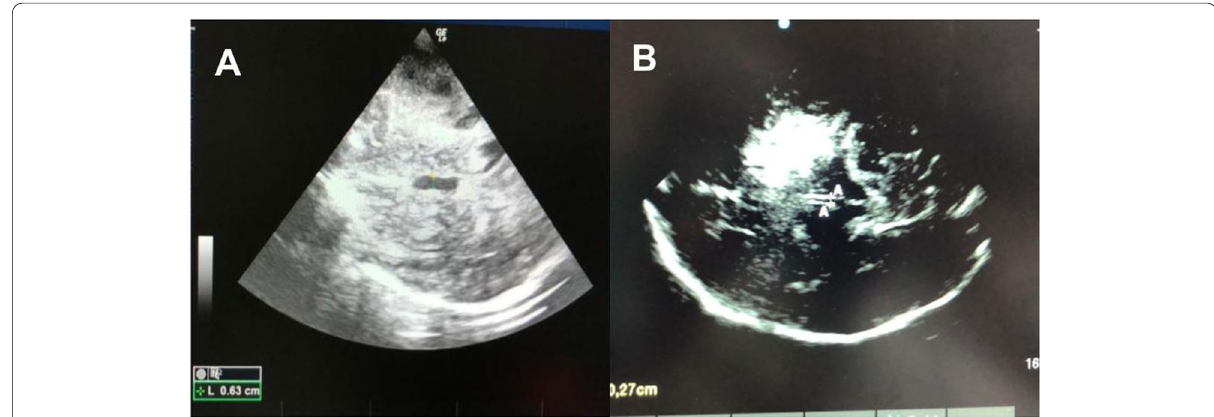
Fig. 6 Diencephalic plane, the third ventricle is obtained (A-A). It should be measured the largest transverse diameter of the third ventricle with its hyperechogenic margins. These figures were performed of two women patients, with same ages, 24h after derivation devices were removed. A Large third ventricles suggesting hydrocephalus. B Normal value without